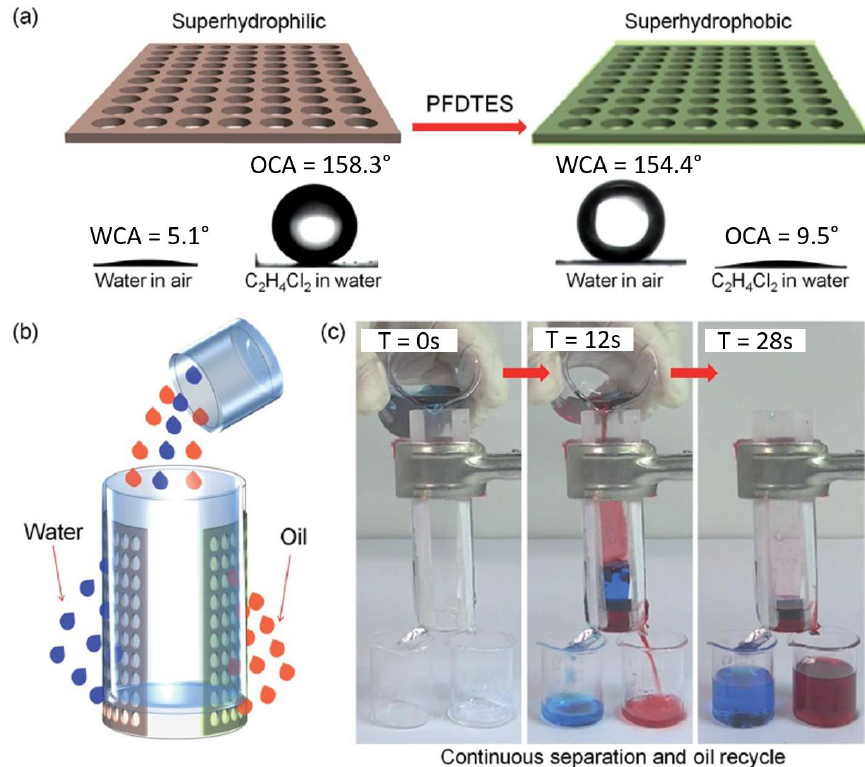
Figure 12. ( a ) Oil – water mixture of heavy and light oil. ( b ) Schematic of the light oil – water separation process; ( c ) oil – water separation was completed within 13 s in the case of the octane light oil. ( d ) Tube with side opening and schematic of the heavy oil – water separation process; ( e ) the heavy oil – water separation process was completed within 31 s [70]. Reproduced with permission from [70] Royal Society of Chemistry 2016.